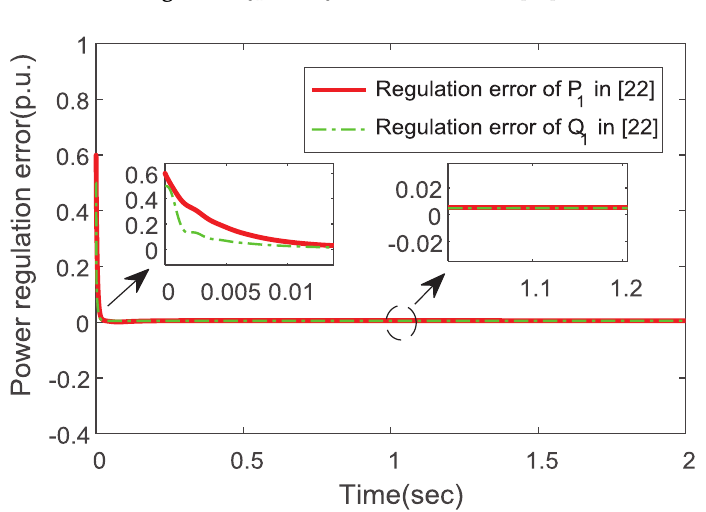
Figure 8. Q 1 and Q r under method in [22].